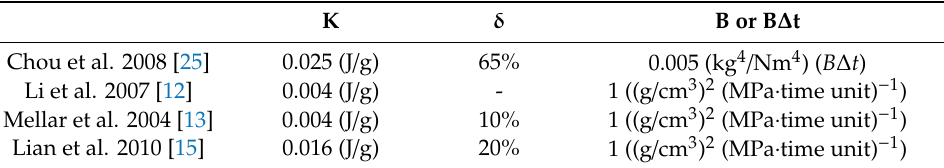
Table 1. Remodeling parameters used in the